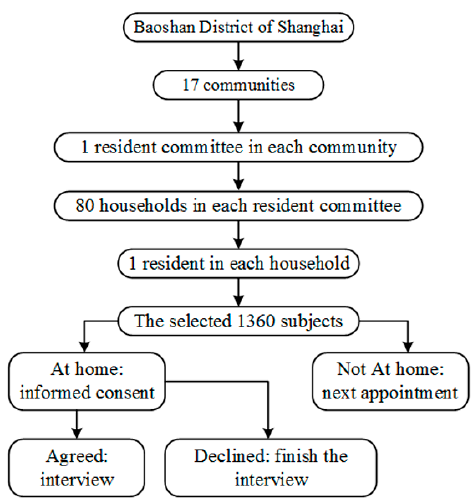
Figure 1. Flow chart for participants sampling and interview in the study on health literacy in a 15– 69-year-old population, Shanghai, China,